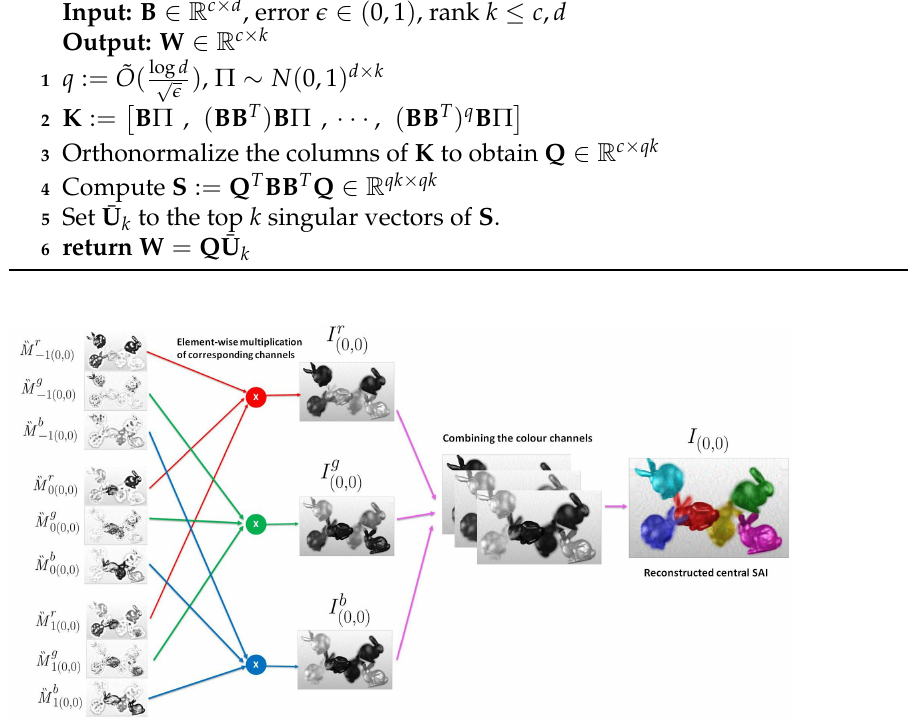
Figure 6. For the central viewpoint ( s ∗ , t ∗ ) = ( 0,0 ) , the decoded layers ` M z are translated to ‚ M corresponding color channels are multiplied element-wise to obtain I ch ( obtained by combining the red, blue, and green color channels.